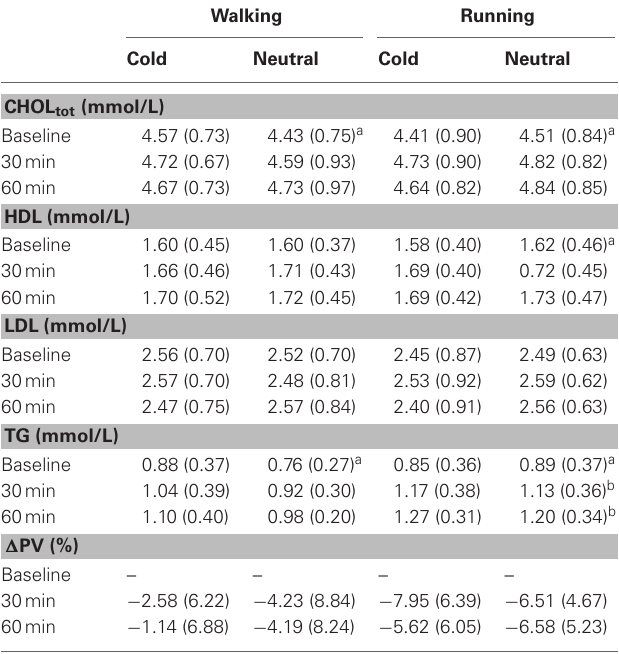
Table 2 | Serum lipids and plasma volume during walking and running in both cold and neutral environmental conditions at baseline and during